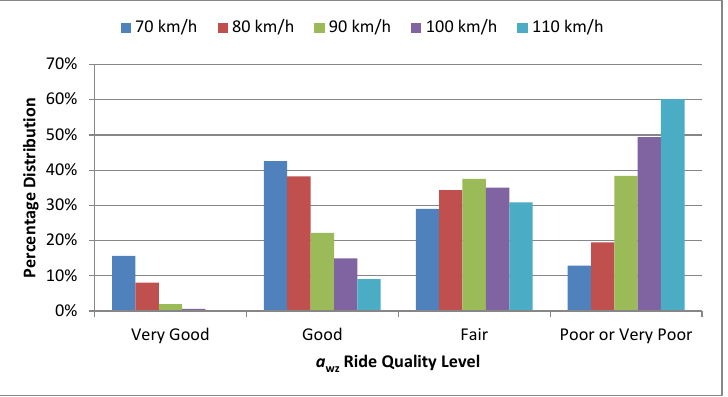
Figure 11. Ride quality level percentage distribution for the real profile samples calculating the a wz at different speeds.